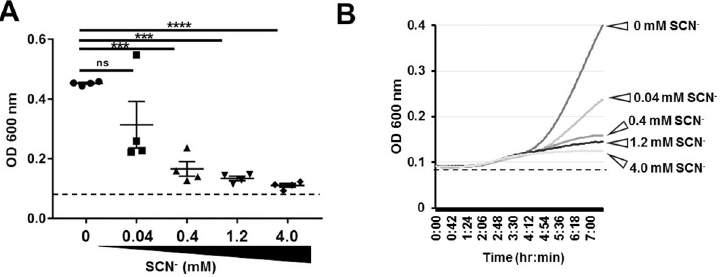
Fig 3. Spn growth is inhibited in a thiocyanate dose-dependent manner. (A) Increasing the concentration of SCN- in the cell-free system leads to improved antimicrobial effect of OSCN - against Spn EF3030. Bacteria were incubated for 6 hrs with LPO, glucose oxidase, glucose and different concentrations of SCN - , and bacterial growth was followed by the microplate-based growth assay (n = 4). Each symbol represents a separate, individual experiment, mean+/-S.E. M. One-way ANOVA and Tukey’s multiple comparison test. (B) Representative kinetics of EF3030 growth curves. Each experiment was done in biological triplicates and each biological replicate was tested in technical triplicates. ��� , p < 0.001; ns, not significant. Dotted lines indicate the OD background of the growth medium without bacteria that was not subtracted in these